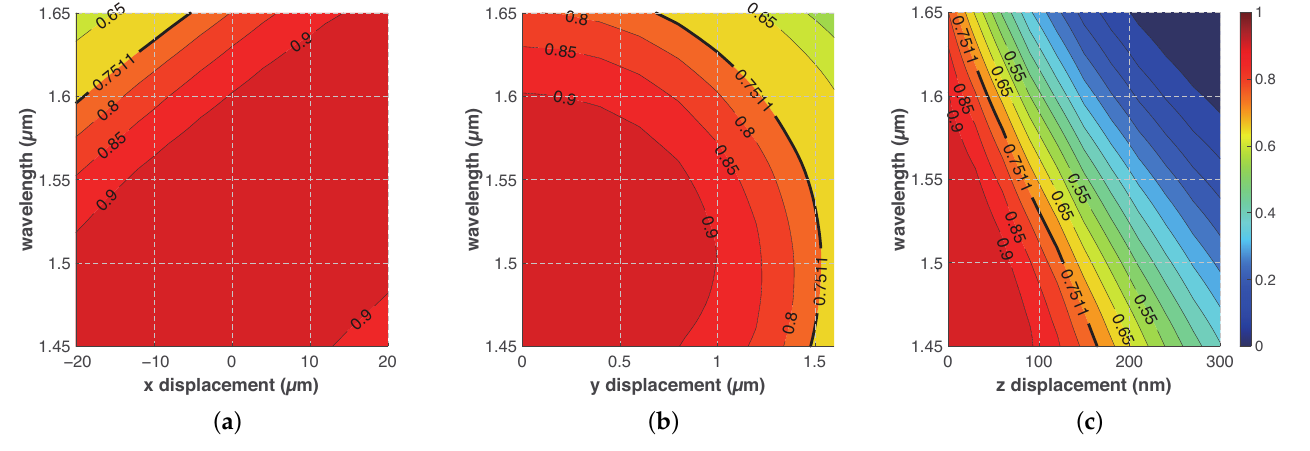
Figure 5. Coupling efficiency with deviation. ( a ) Efficiency against x -axis displacement. ( b ) Efficiency against y -axis displacement. ( c ) Efficiency against z -axis